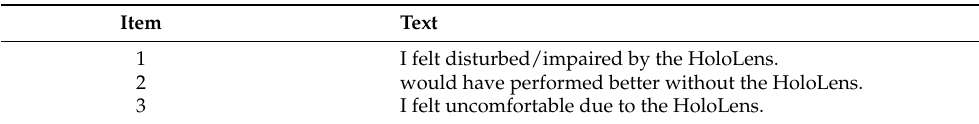
The adapted items of the interference scale originally developed by Kapp et al. [57] (translated for this